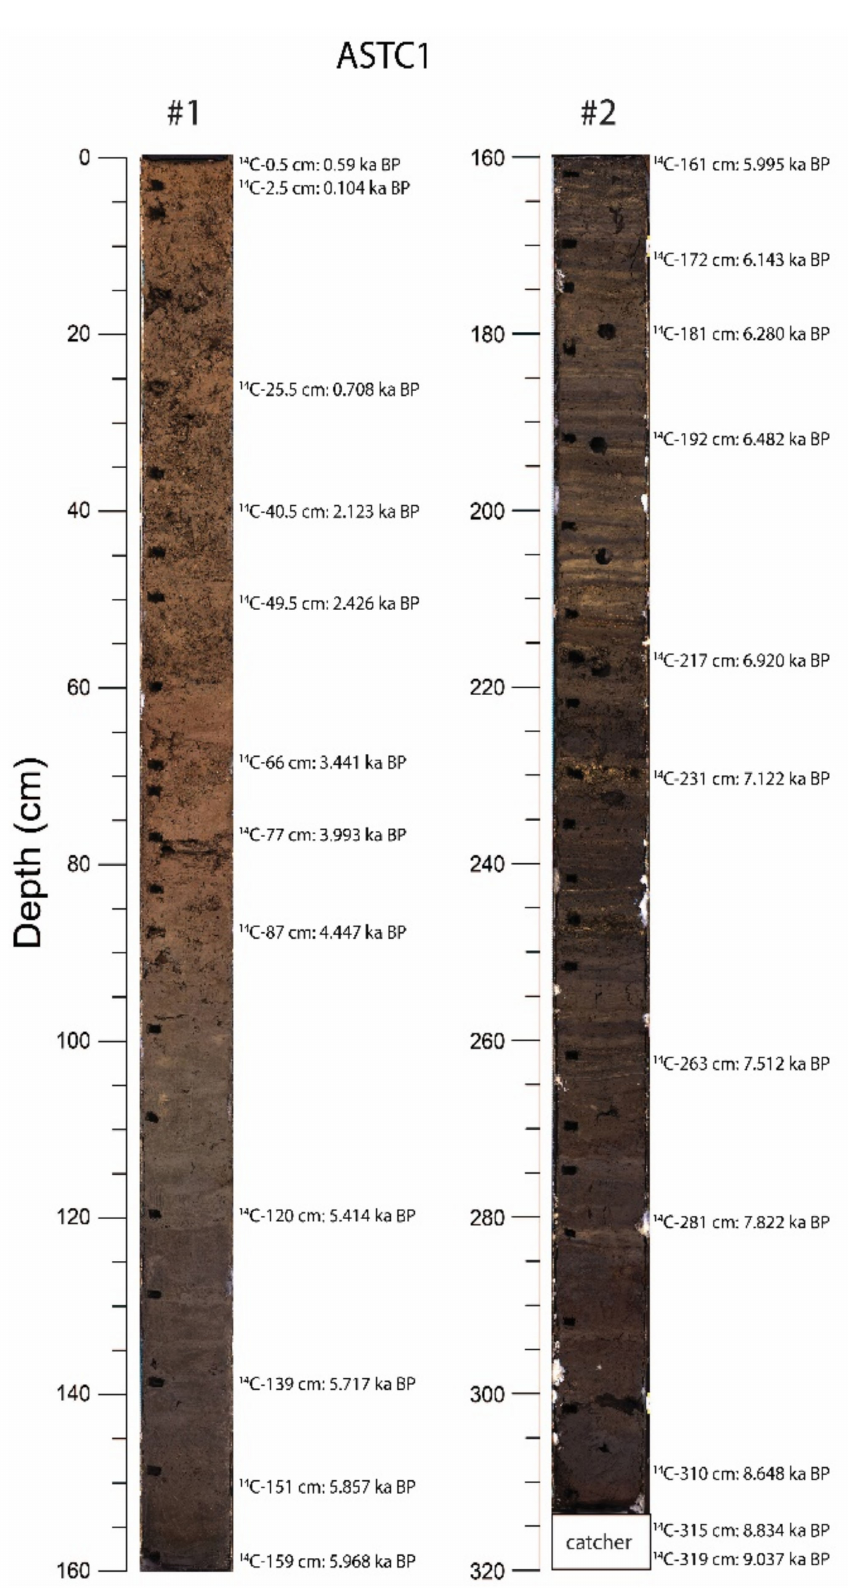
Figure 4. Calendar 14 C dates measured along the two sections of the ASTC1 sediment